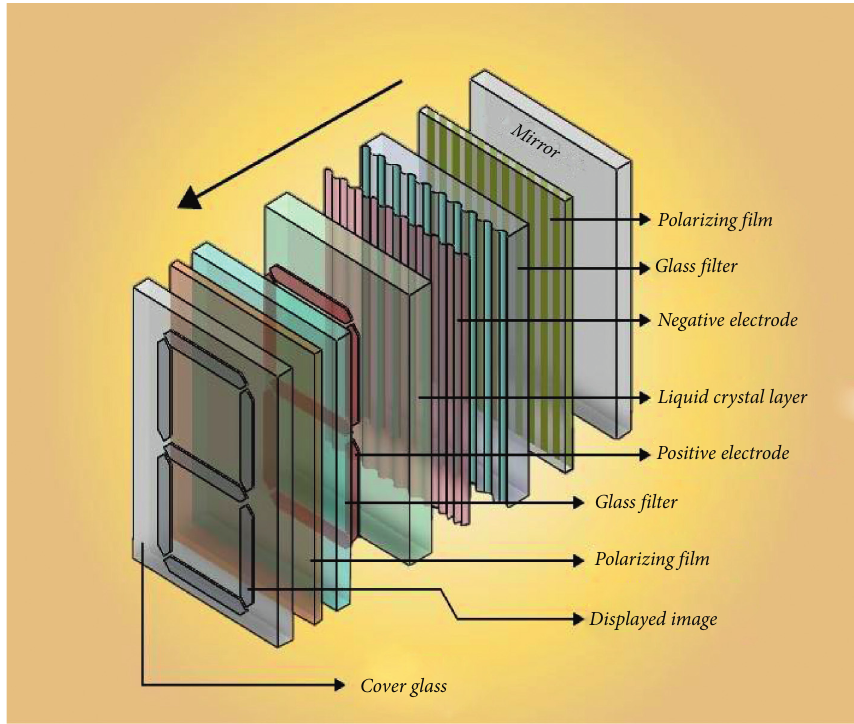
Figure 1: Structure of a typical LCD.